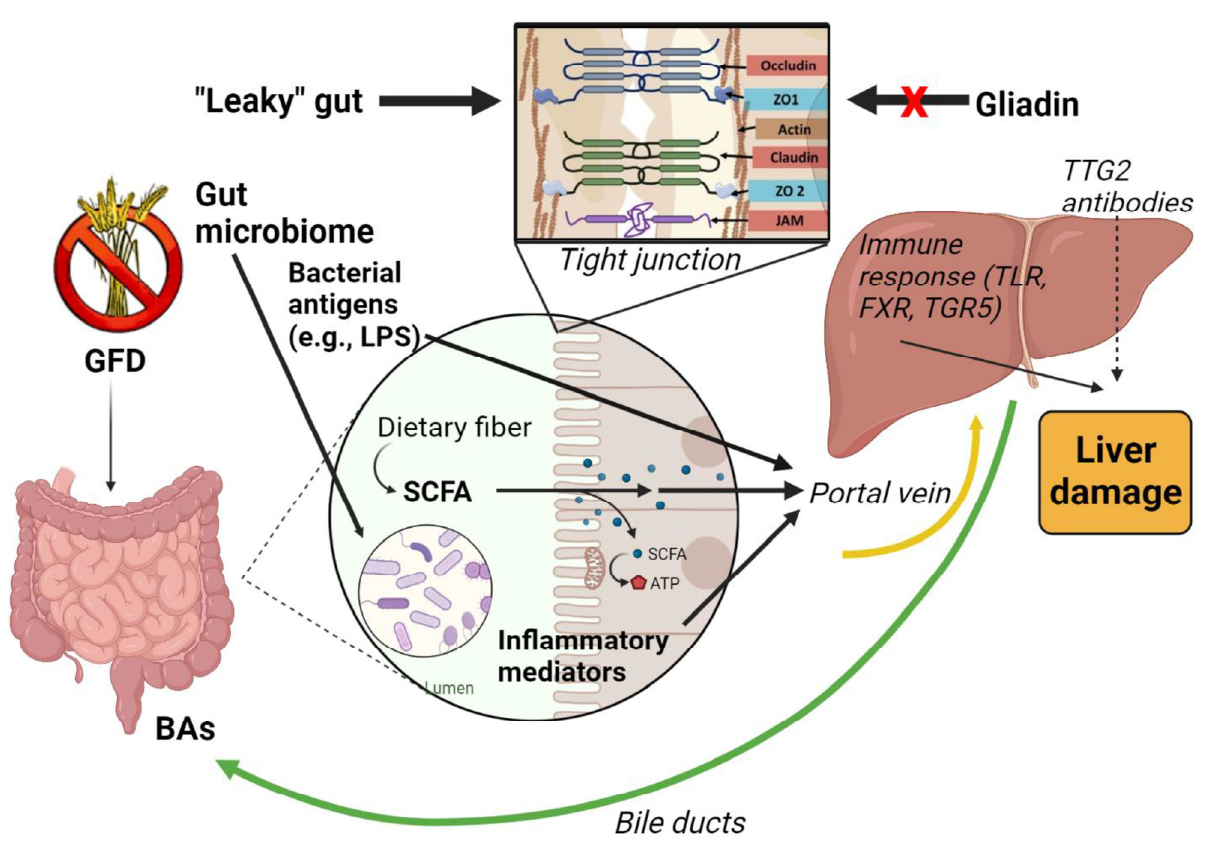
Figure 1. The homeostasis of the intestinal–liver axis is ensured by a healthy intestinal barrier and a balanced and functional microbiome, which act in parallel by preventing elevated levels of toxic substances from reaching the liver through the portal circulation. Increased permeability, dysbiosis, and the production of toxic metabolites may combine to determine a pathological gut–liver axis that contributes to the pathogenesis of NAFLD. Created with BioRender.com (accessed on 13 January